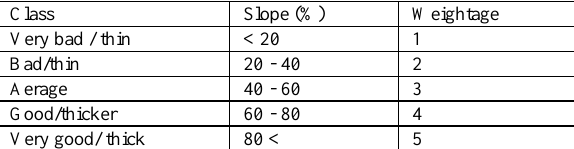
TABLE 4. Classification of vegetation cover.